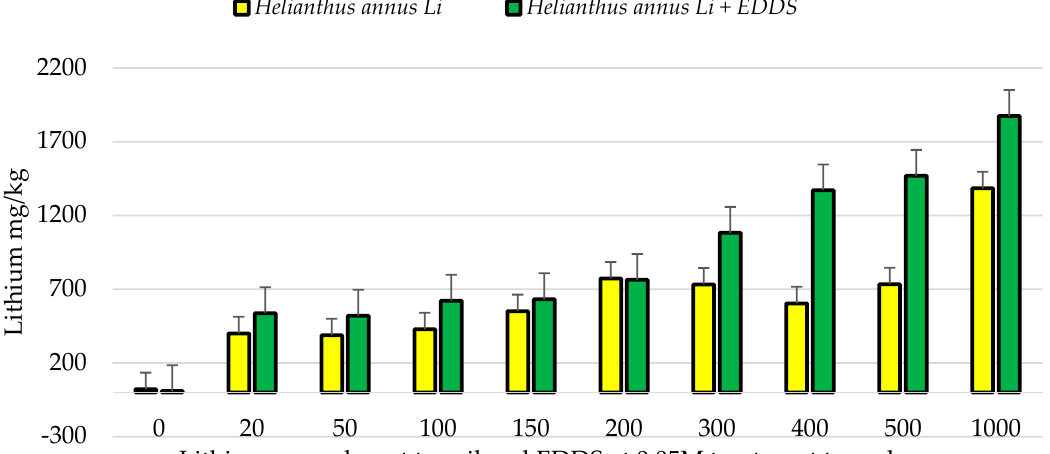
Table 4. x ̅ maximum Li levels, standard deviations and maximum levels of Li in plants from all 3 trials (units in mg/kg).